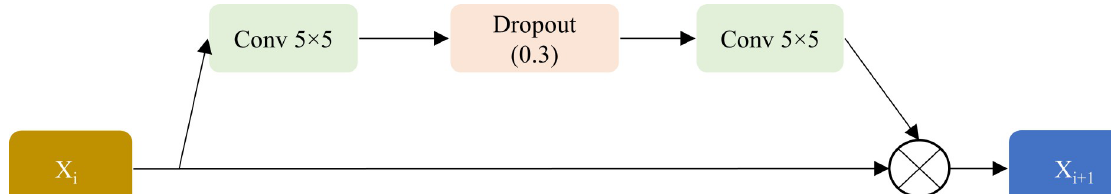
Fig 4. A custom wide residual network (WRN) with dropout regularization.